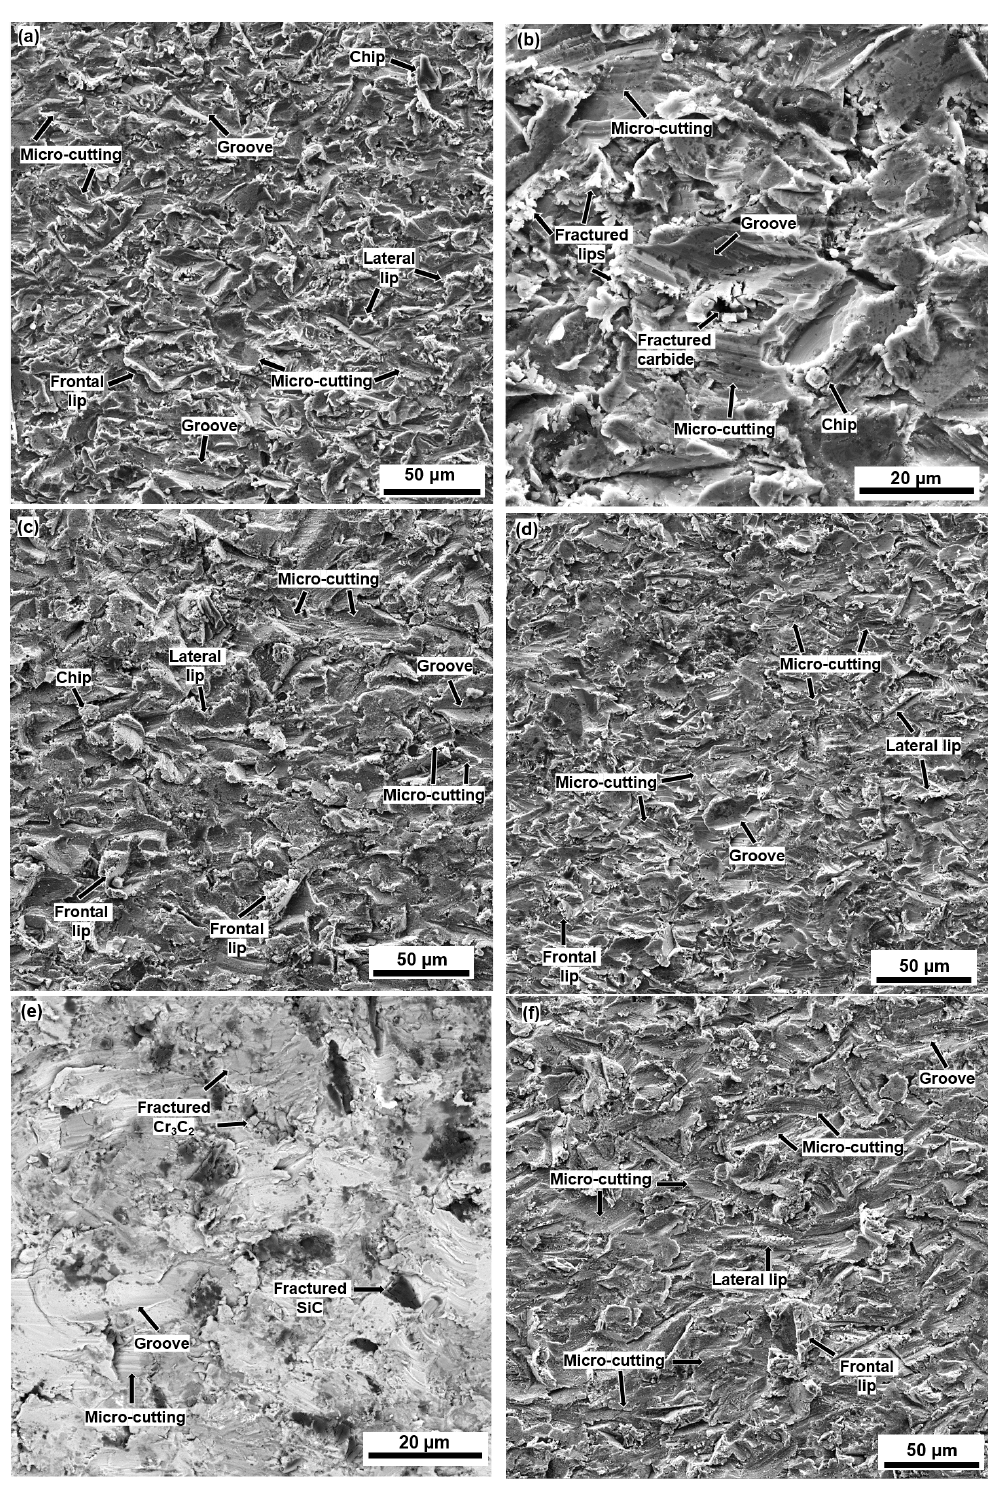
Figure 11. Eroded surface 30° angle: ( a ) and ( b ) C1 at RT; ( c ) at 900 °C. ( d ) C2 at RT; ( e ) RT, backscattered electrons; and ( f ) at 900 °C.